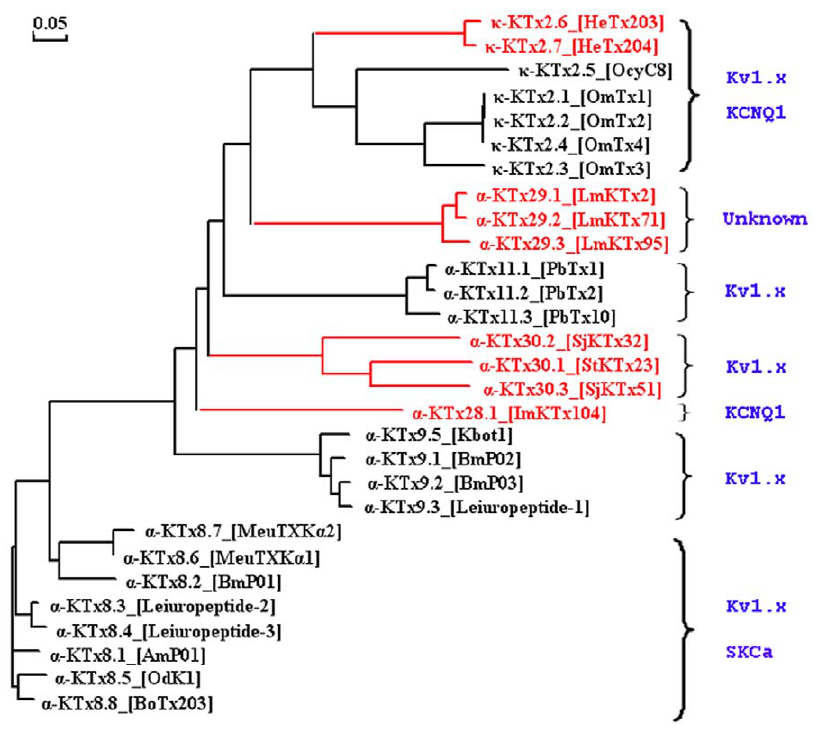
Figure 8. Molecular diversity of acidic KTxs. Sequence alignment of nine new KTxs with all known acidic KTxs. The nine new acidic KTxs are marked in red and their possible targets are shown.